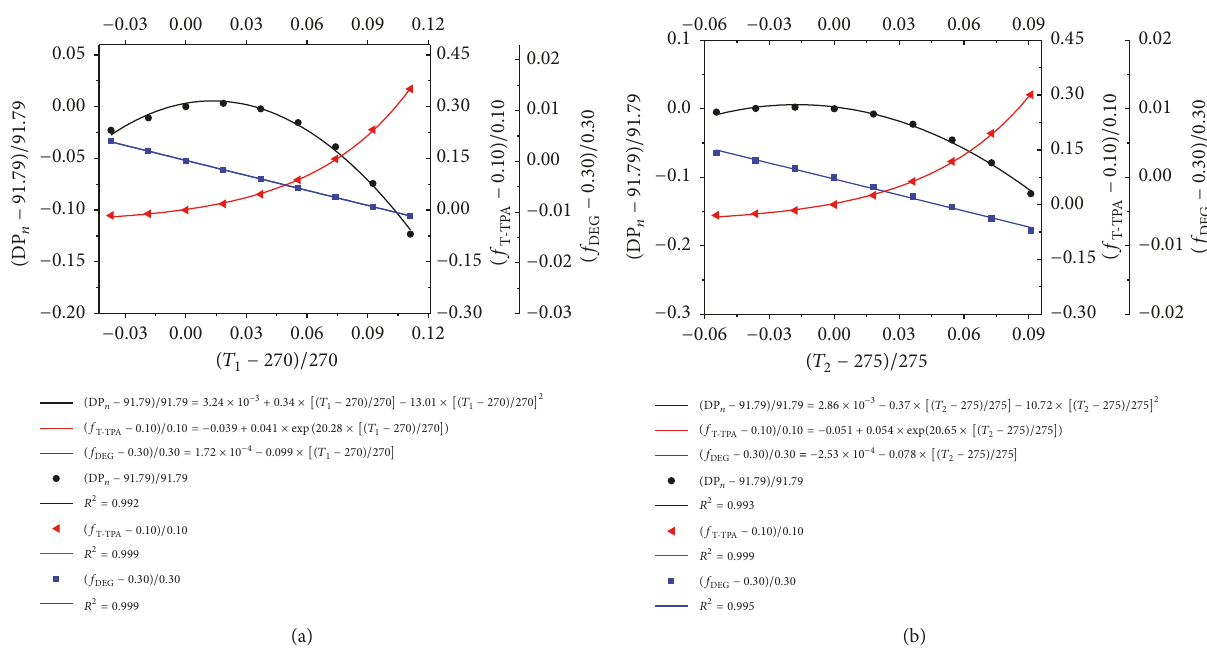
Figure 5: Effects of temperature in (a) falling film reactor and (b) rotating disk reactor on quality indexes of liquid polymerization product.